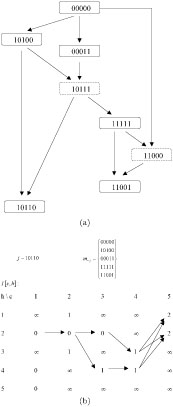
An example of recombination intermediates (a) and computation of Ij [m−j] (b).